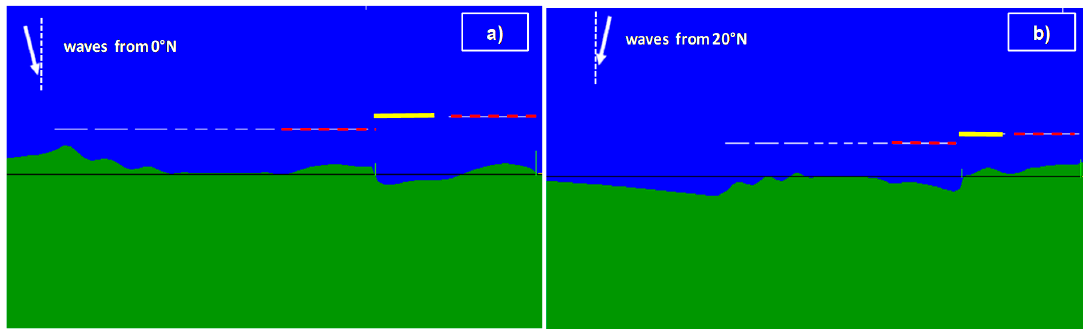
◦ N ( a ) and 20 ◦ N ( b ). K A2 to waves from 0